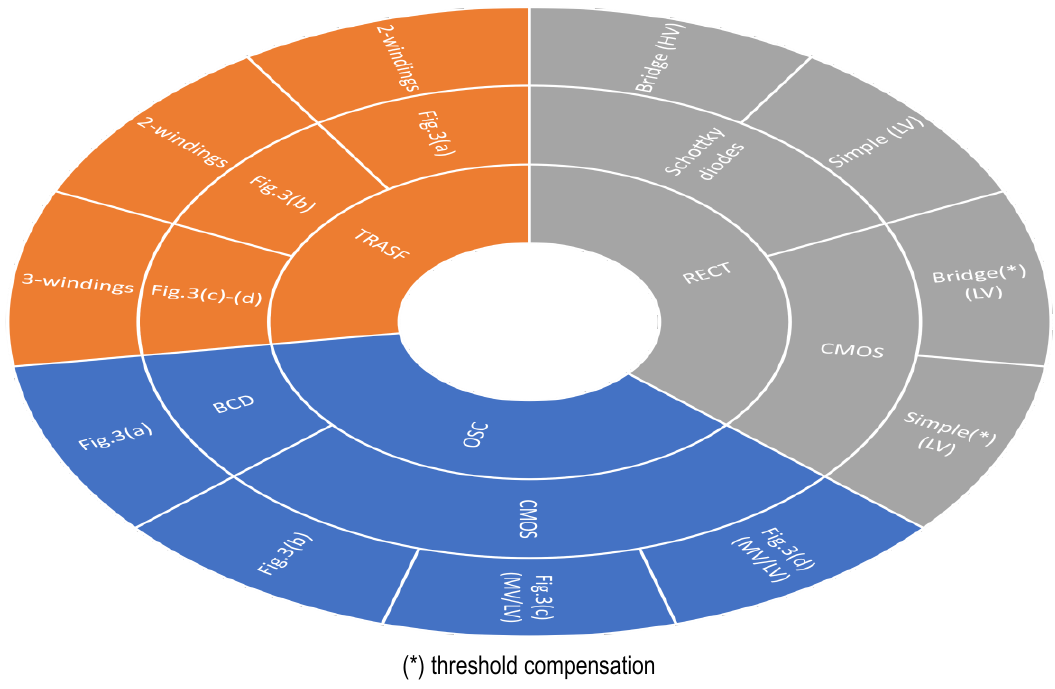
Figure 5. Building block topology selection for galvanically isolated DC-DC converters.